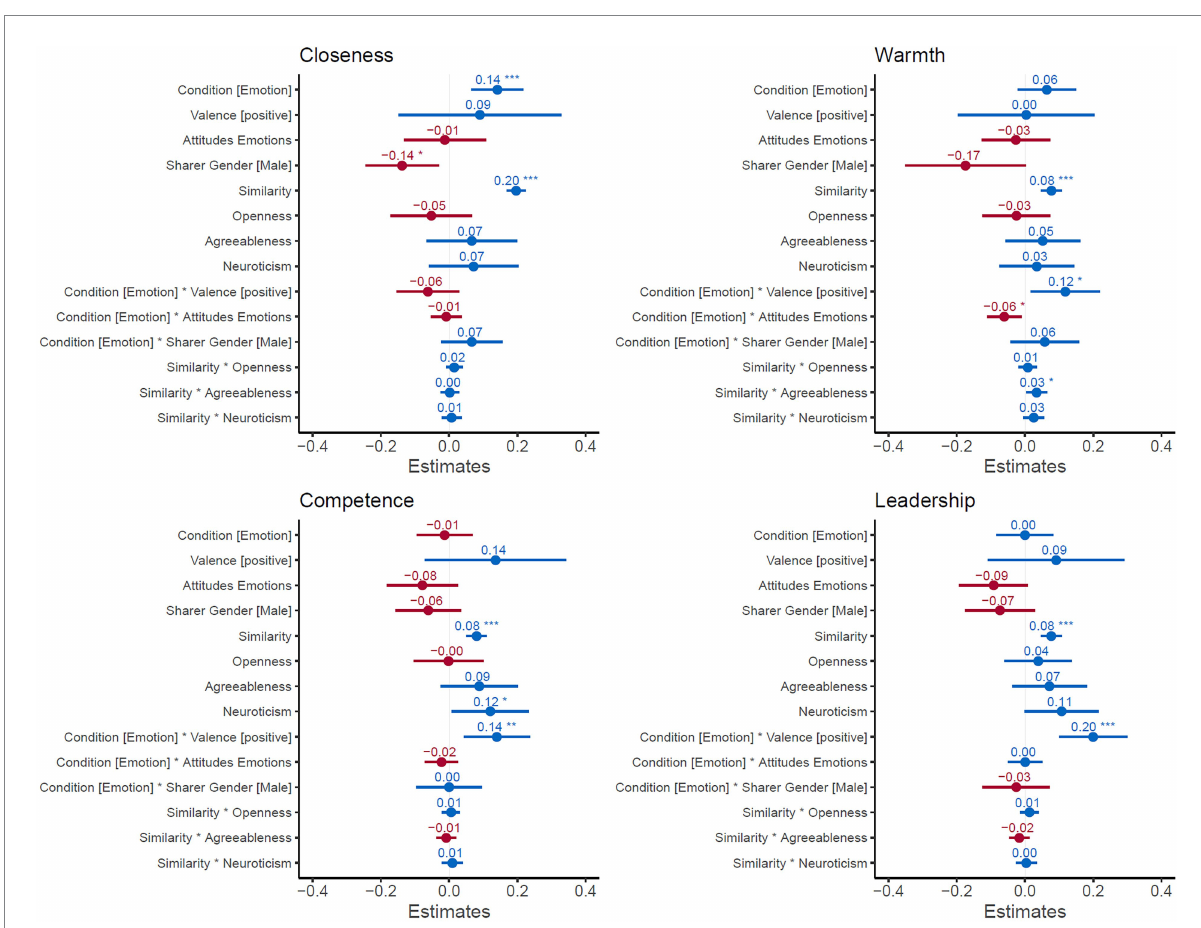
FIGURE 4 Mixed-Effects Models Predicting the Four Outcome Variables Based on Variables of Interest. Shown are the beta weights with 95% confidence intervals. Condition (Emotion vs. NoEmotion), valence, sharer gender, and similarity ratings are trial-level variables. Attitudes, Openness, Agreeableness, and Neuroticism are participant-level variables. Random effects included random intercepts for participant, stimulus picture, and sentence. Plot was created using the sjPlot package in